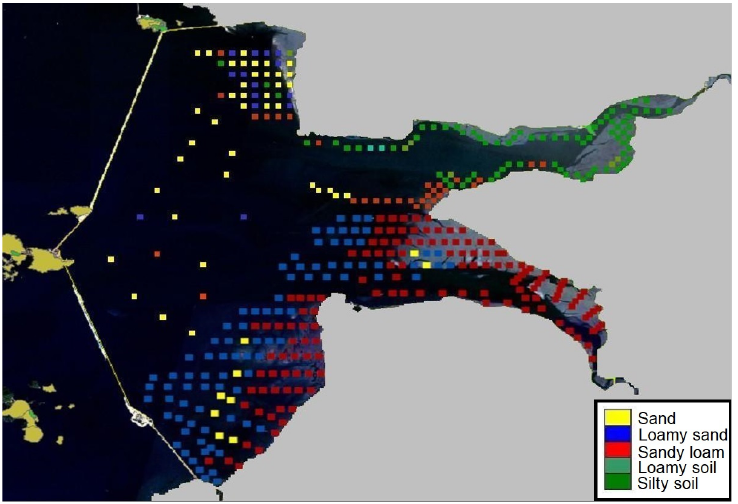
Figure 5. Soil distribution in Saemangeum, South Korea at shallow depths.